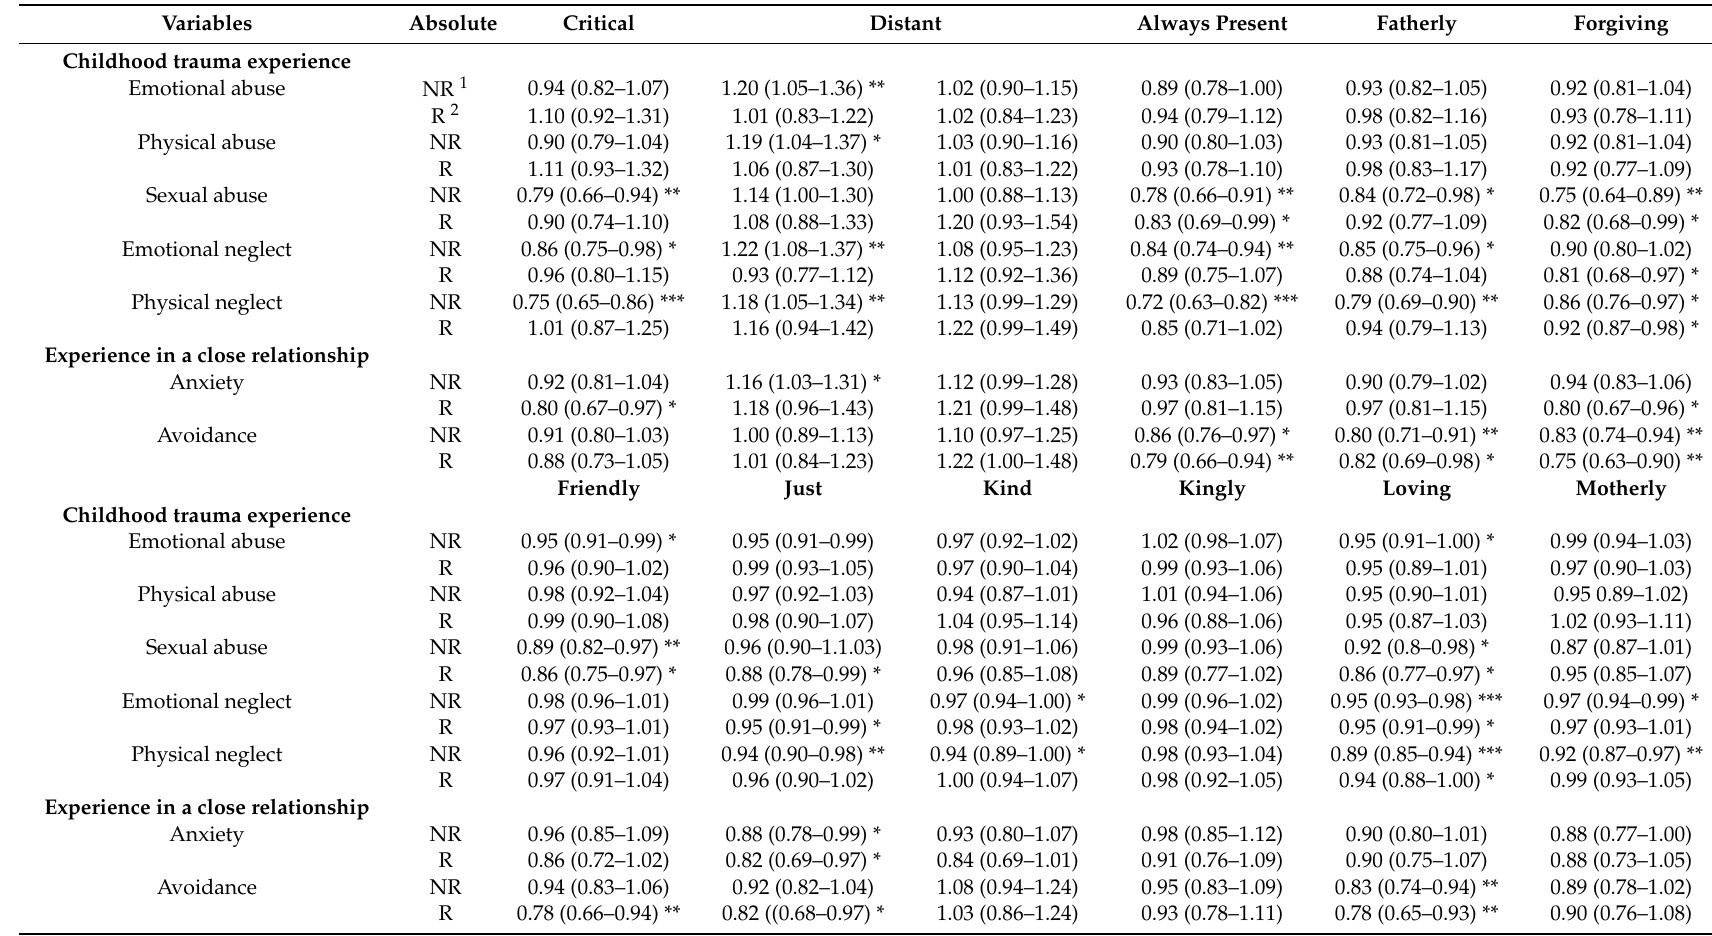
Table 2. Associations of di ff erent childhood trauma experiences and the experiences in close relationships (both standardized to z-scores) with di ff erent images of God: results of binary logistic regression adjusted for age, gender and education level leading to odds ratios (OR) with 95% confidence intervals (95%